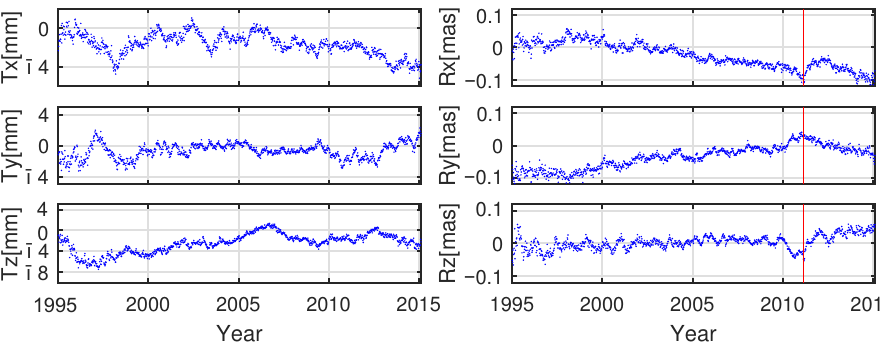
Figure 10. Time series of the translation and rotation parameters estimated between JTRF2014 and IGS after subtracting the annual and semiannual signals. Table 3. Offsets at epoch 2010.0 and drifts obtained from linear regressions to the transformation parameter time series estimated between JTRF2014 and IGS. Note: the standard deviations of the transformation parameters are the results after the annual and semi-annual signals were subtracted.